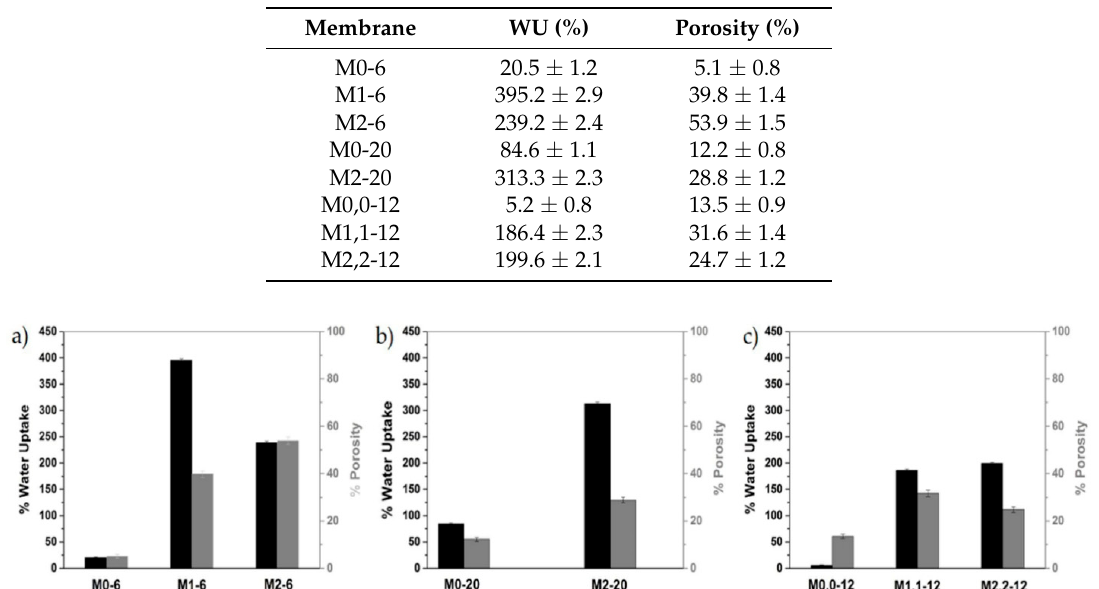
Figure 12. Schematic representation of WU and porosity values for the membranes ( a ) M0-6, M1-6, and M2-6; ( b ) M0-20, and M2-20; and ( c ) M0,0-12, M1,1-12, and M2,2-12.